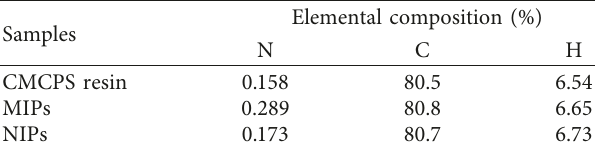
Table 1: Element analysis of the MIPs. Samples